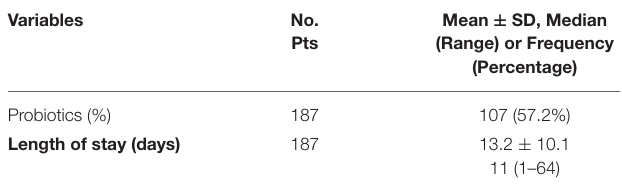
TABLE 1 | Baseline characteristics of ulcerative colitis (UC) patients.